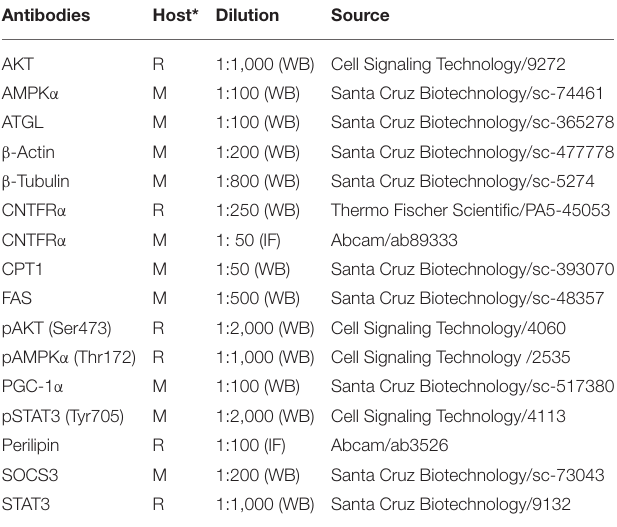
TABLE 1A | Taqman probes all from Applied Biosystems #4453320. Target gene